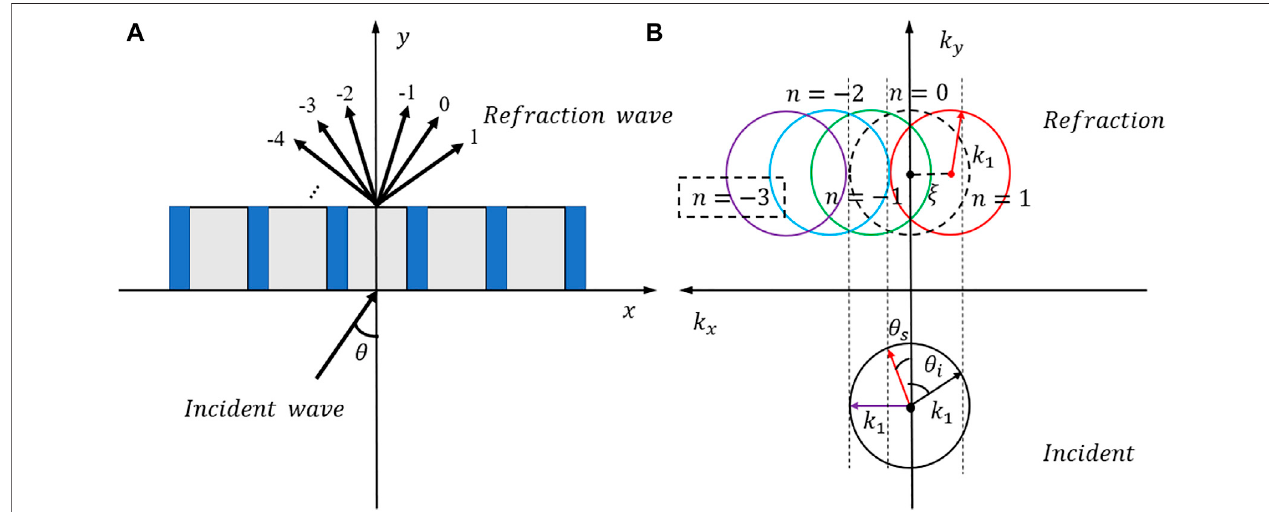
FIGURE 1 | (A) high-order diffraction phenomenon of periodic structure; (B) interpretation of the angular correspondence between the incident and transmitted waves by means of wave vectors.